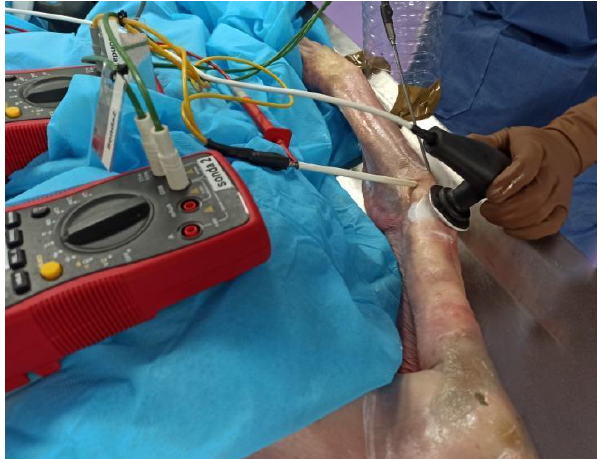
Figure 2. Invasive placement of the thermocouples in the common extensor tendon and the radio- humeral capsule.